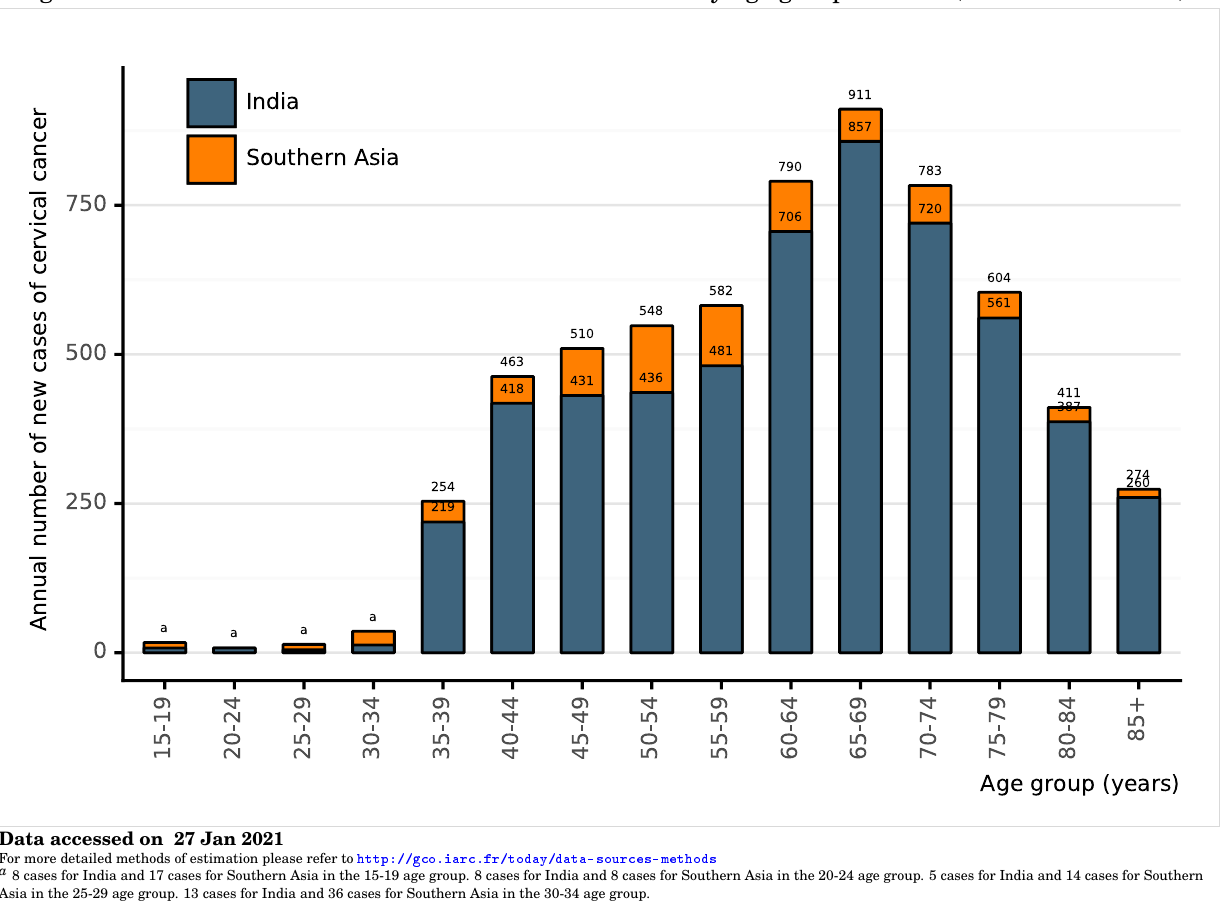
Figure 85: Annual number of new cases of cervical cancer by age group in India (estimates for